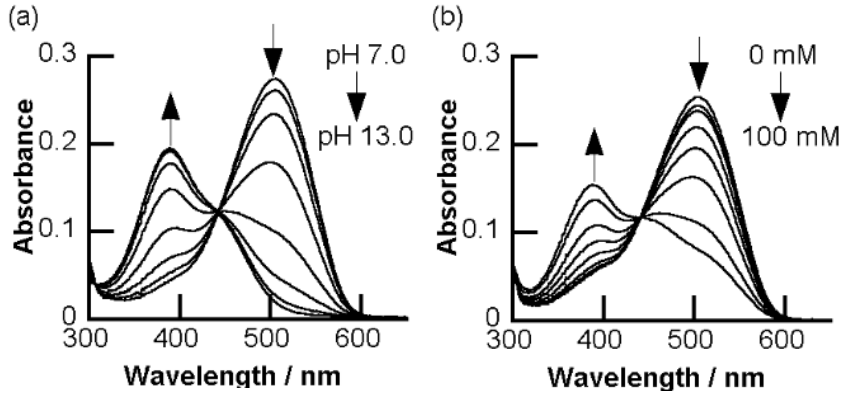
Figure 7. Solutions of dye 7 (20 μM) in CHES buffer (10 mM, pH 10.0), ( a ) in the absence of sugar; and ( b ) in the presence of 100 mM of D -fructose. Reprinted with permission from [65]. Copyright 2007 Elsevier Besloten